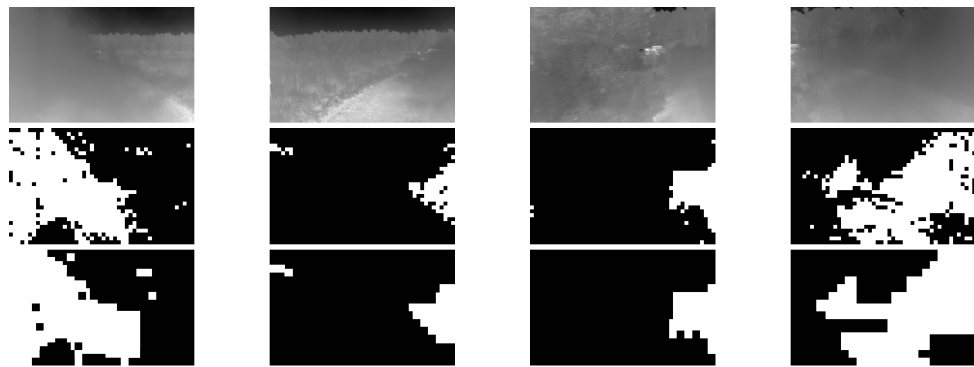
Figure 8. Qualitative results from running tests with varying the window size. The top row is the input image, the middle row shows the results with window size of 64 × 64, and the bottom row shows the masks generated from 32 × 32 tiles.